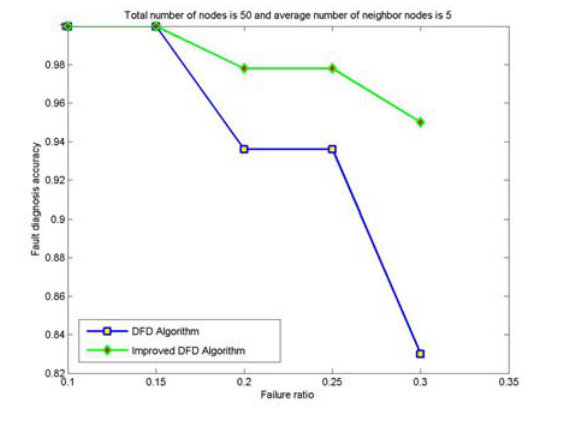
Figure 7. The node fault detection accuracy with various node failure ratios when 50 nodes are randomly deployed and the average numbers of neighbor nodes is